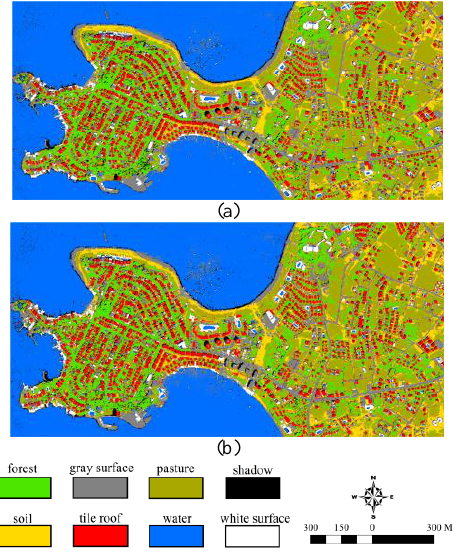
Figure 4. Thematic maps produced using pixel-based image analysis technique by (a) XGBoost, (b)